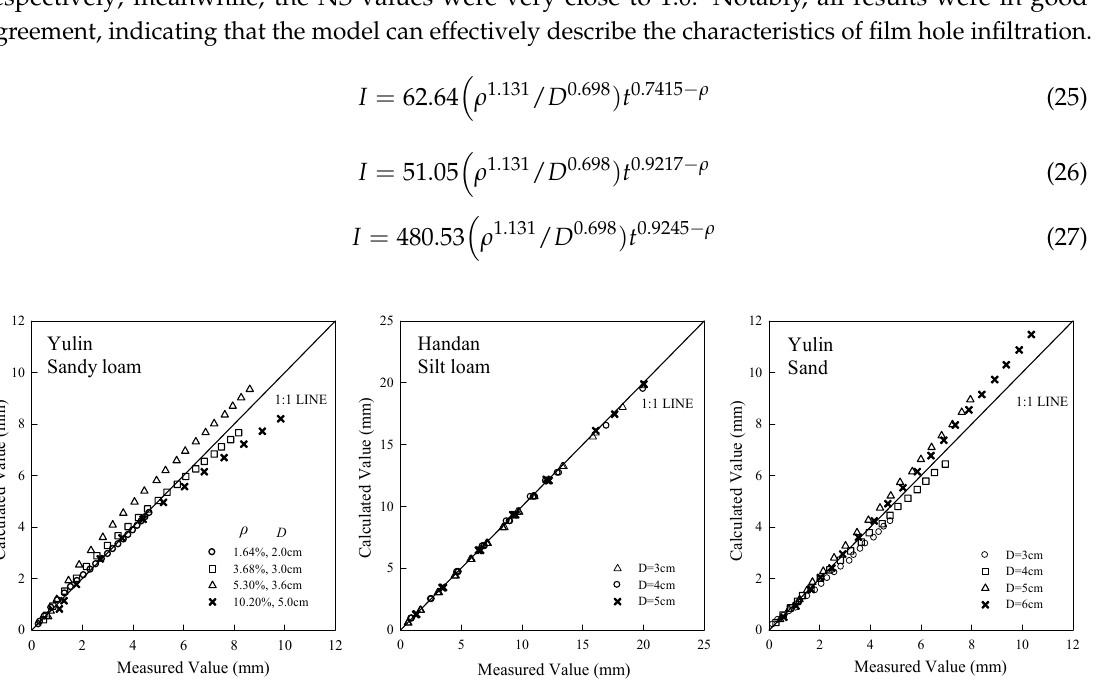
Figure 12. Comparison of three infiltration models (cited from published studies) between calculated and measured values of cumulative infiltration. Table 5. Correlation between measured and calculated values of cumulative